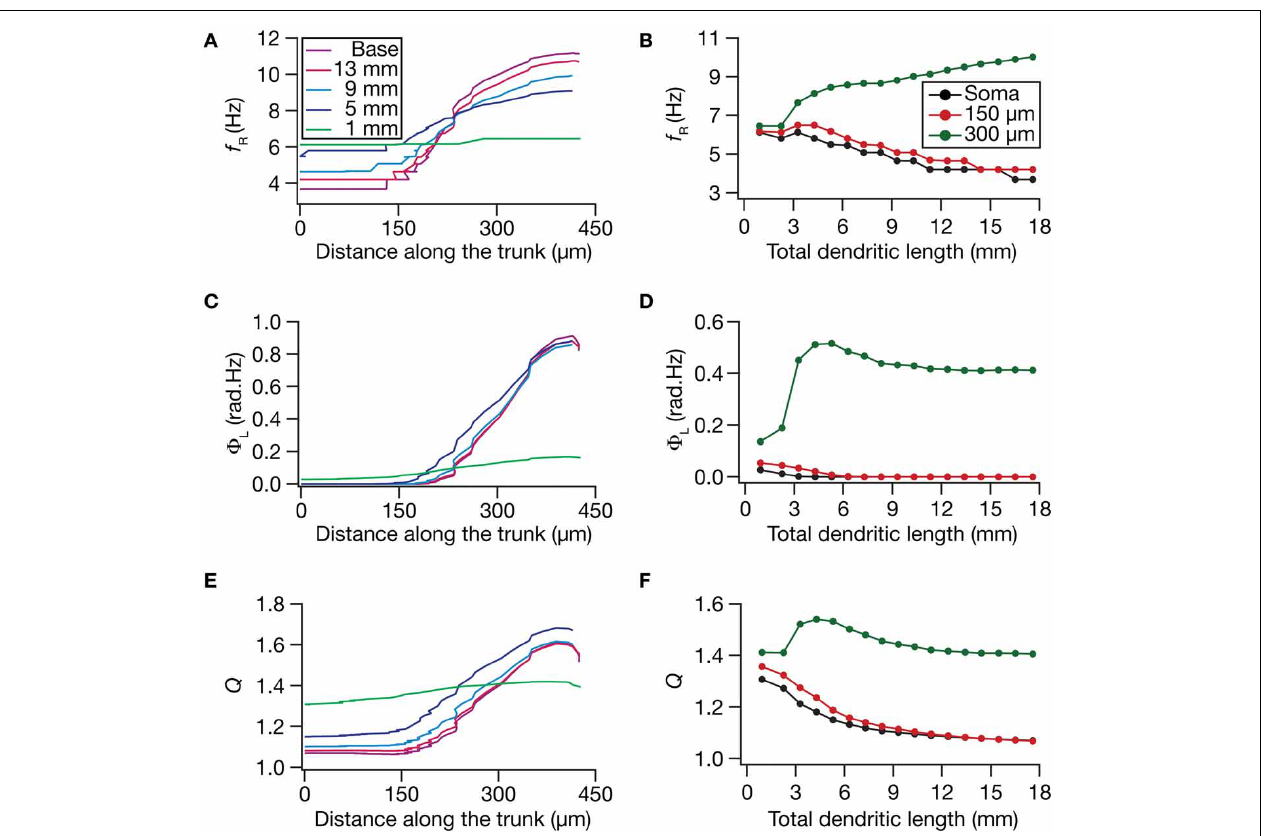
FIGURE 5 | Functional maps of several HCN-channel-dependent local impedance measurements were critically regulated by dendritic atrophy. (A,B) Local resonance frequency ( f R ) plotted as functions of distance from the soma ( A ; for 5 different pruned morphologies, Figure 1A ) and total dendritic length ( B ; for 3 distinct somatodendritic